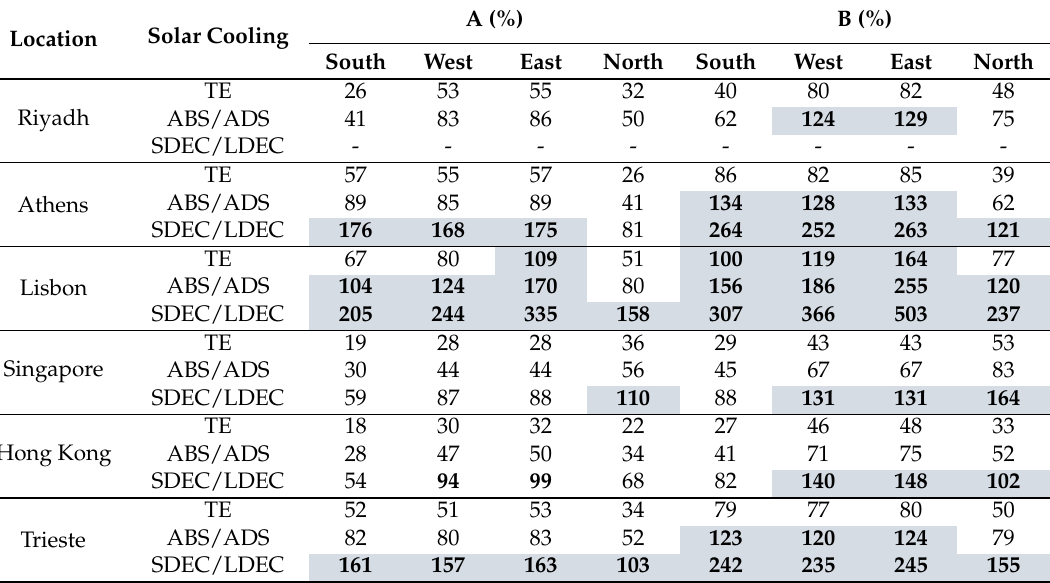
Table 8. Solar fraction for scenarios A and B in all locations and